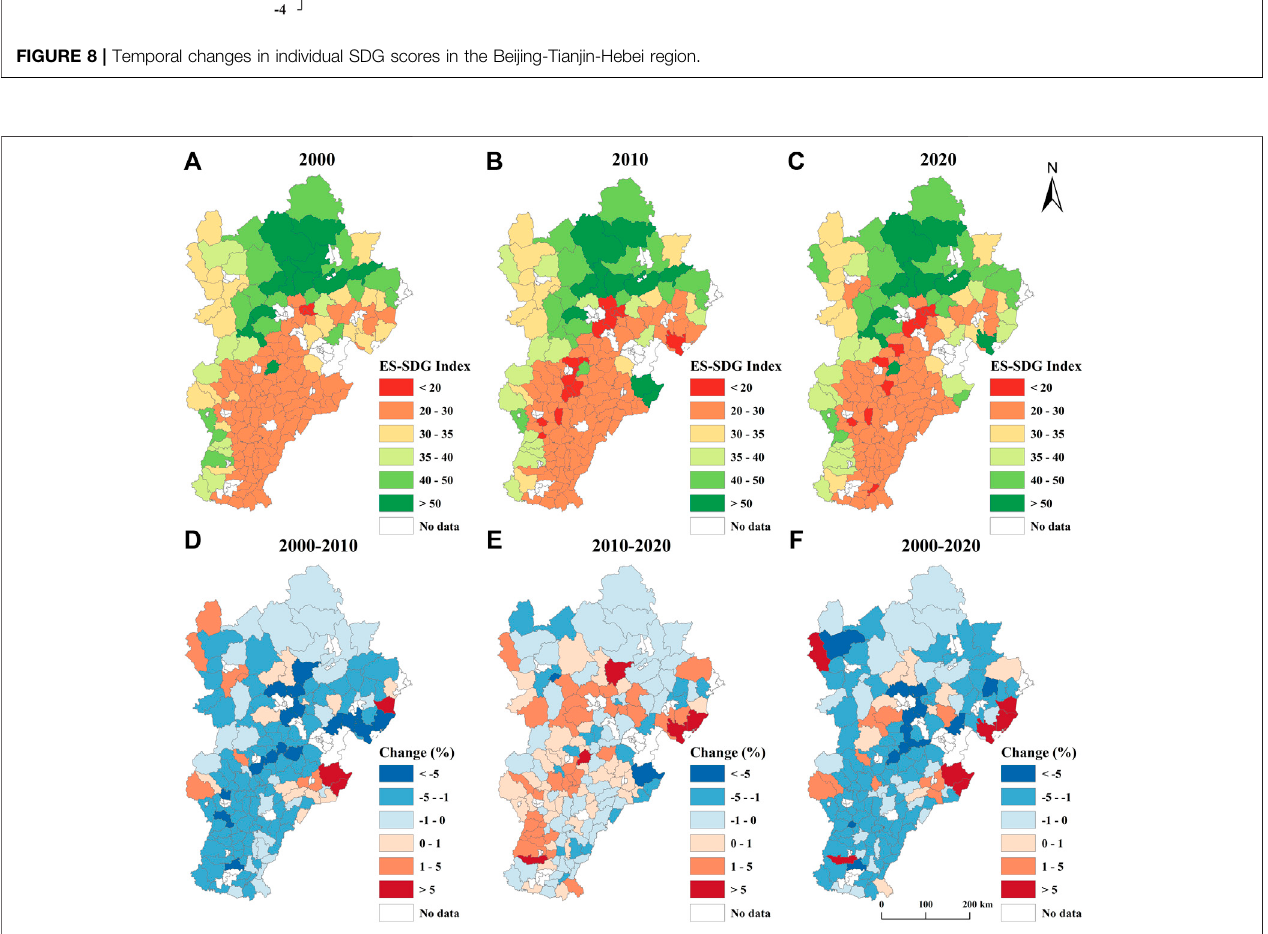
FIGURE 9 | Spatial-temporal changes in ES-SDG Index scores in the Beijing-Tianjin-Hebei region.